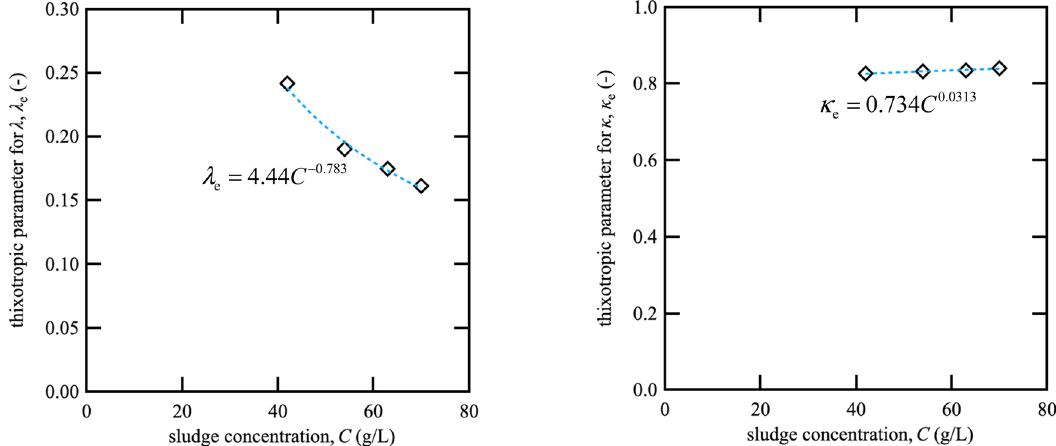
Figure 3 : Change in thixotropic parameters, λ e ( left ) and κ e ( right ) with C